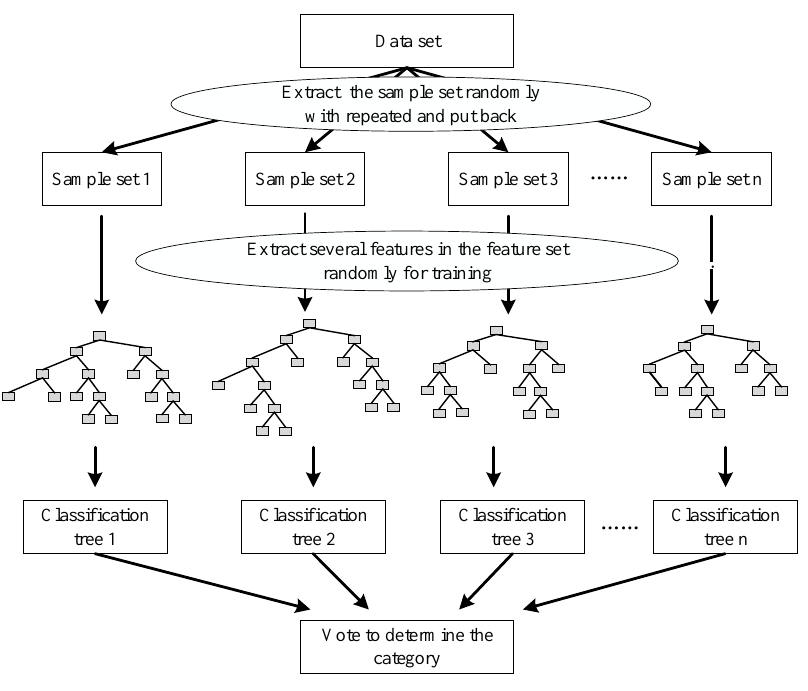
Figure 3. The process of establishing a random